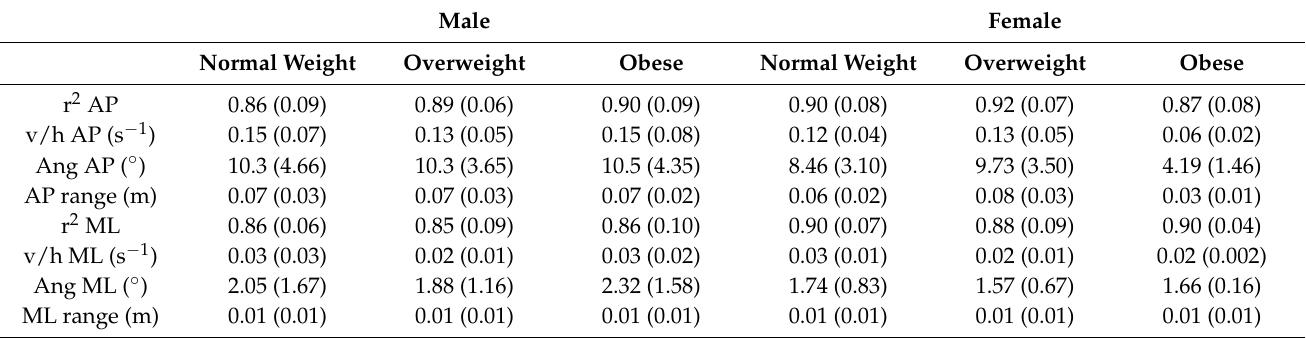
Table 4. Mean and standard deviation values of parameters extracted from the CoP in the antero– posterior (AP) and medio–lateral (ML) directions for children with Down syndrome and flat feet divided into males and females and according to weight class (normal weight, overweight, and obese). r 2 , coefficient of determination; v/h, mean CoP velocity normalized with respect to height; Ang, angle of inclination of the line interpolating the analyzed CoP displacement trait; range, range of the CoP (max coordinate–min coordinate). Male Female Normal Weight Overweight Obese Normal Weight Overweight Obese